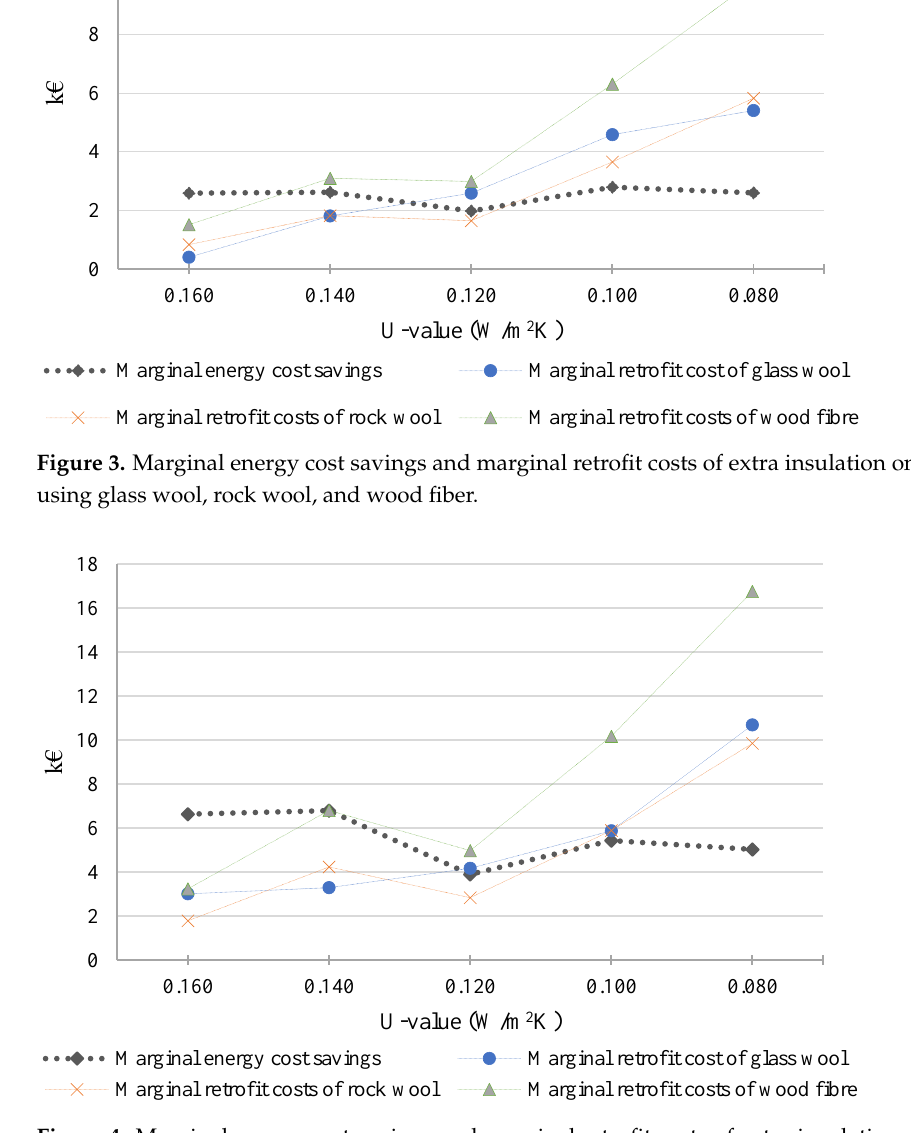
Figure 4. Marginal energy cost savings and marginal retrofit costs of extra insulation on external walls using glass wool, rock wool, and wood fiber.